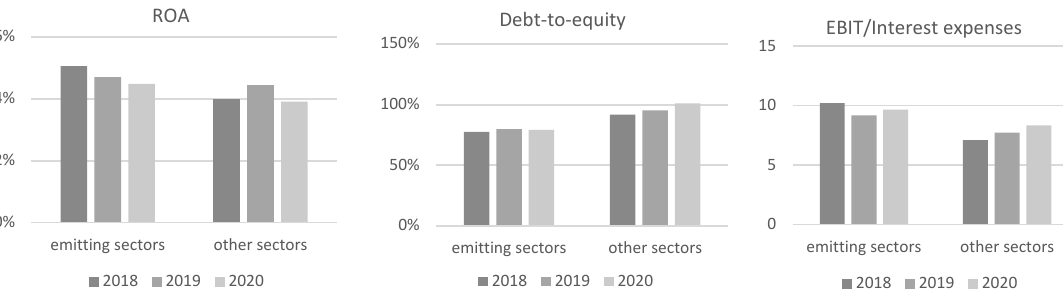
Figure 6. Corporate structure liabilities: emitting sectors versus other sectors. Commercial and cooperative banks have relatively significant exposure to enter- prises operating in emission industries. The portfolio of emitter entities accounts for ap- proximately 40% of the commercial banking exposure of non-financial enterprises and 44% for the cooperative banking sector. However, it is worth noting that the scale of ex- posure to emitting entities is not the same as banks’ exposure to climate risk. The analysis of the impact of climate risk on the financial system requires the use of more fine-grained data. Commercial bank exposures to the energy sector prove to be more risky (Figure 7). The above-mentioned risk for banking industry could be reduced by a significant propor- tion of short-term loans—most corporate loans are repaid within 2–3 years, which leaves some freedom for the banking sector in shaping exposure to climate risk and (partial) transition to “green” projects at the expense of “brown”. There is a high level of concentration of issuance exposures among credit institutions in Poland. The top seven banks take approximately 50% of the total exposure to the emis- sion sectors (Figure 8). In 60% of banks, carbon exposures account for over 30% of the entire portfolio of non-financial enterprises. Risks arising from this can shift to higher probability of default, collateral erosion, and the erosion of asset values in the event of sudden change.